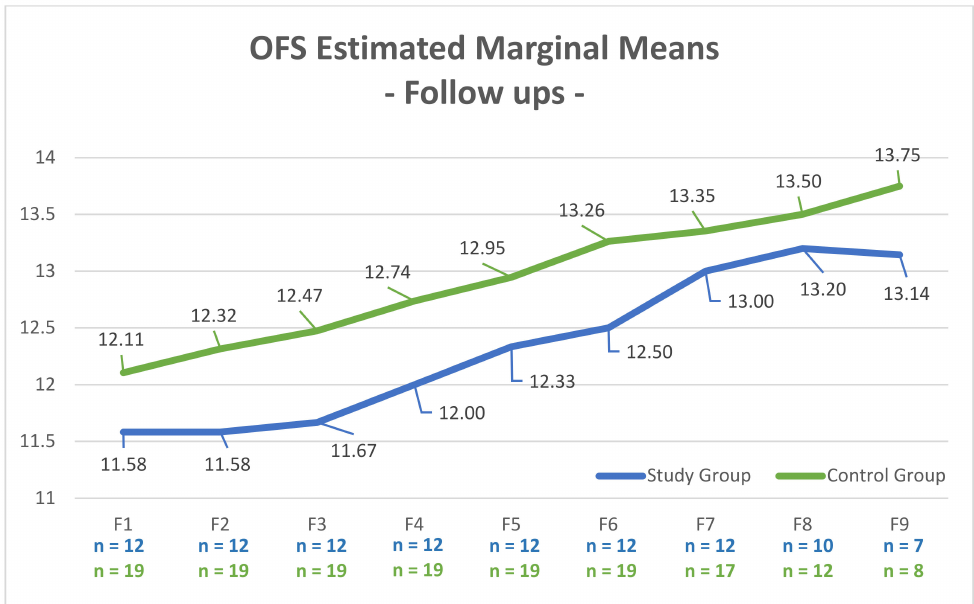
Figure 12. Evolution of the OFS-estimated marginal means in both the study and control groups during the follow-up periods. Y -axis: OFS (Open Field Score); F1 (7 days); F2 (15 days), F3 (one month), F4 (three months), F5 (six months), F6 (one year), F7 (two years), F8 (three years); F9 (four